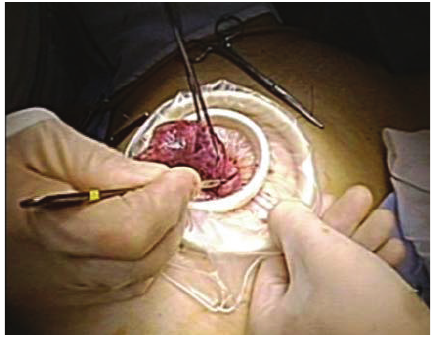
Figure 5: Extracorporeal extraction of excised myoma was per- formed through the umbilical incision by in-bag manual morcella- tion using a number 11 surgical blade.